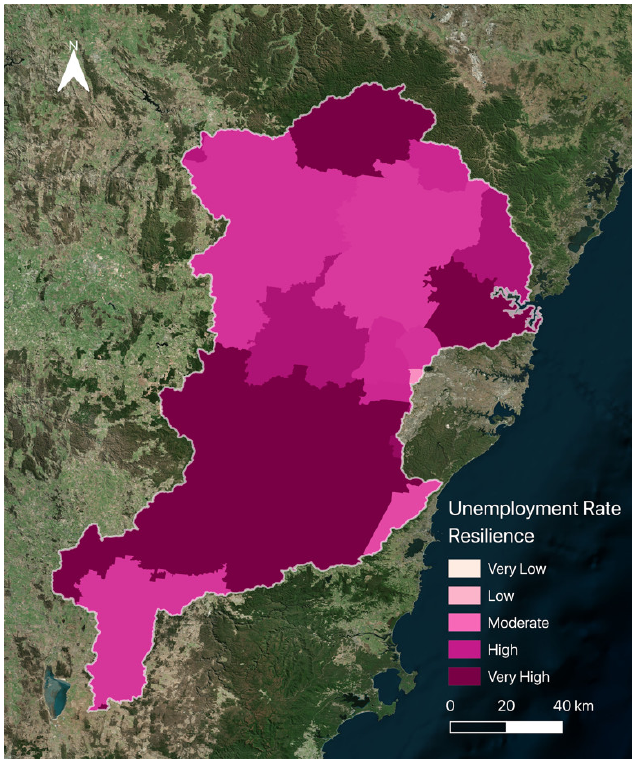
Figure 6. Unemployment Rate resilience after standardising using fuzzy membership processing. Resilience measured from Very Low (light pink) to Very High (dark pink).